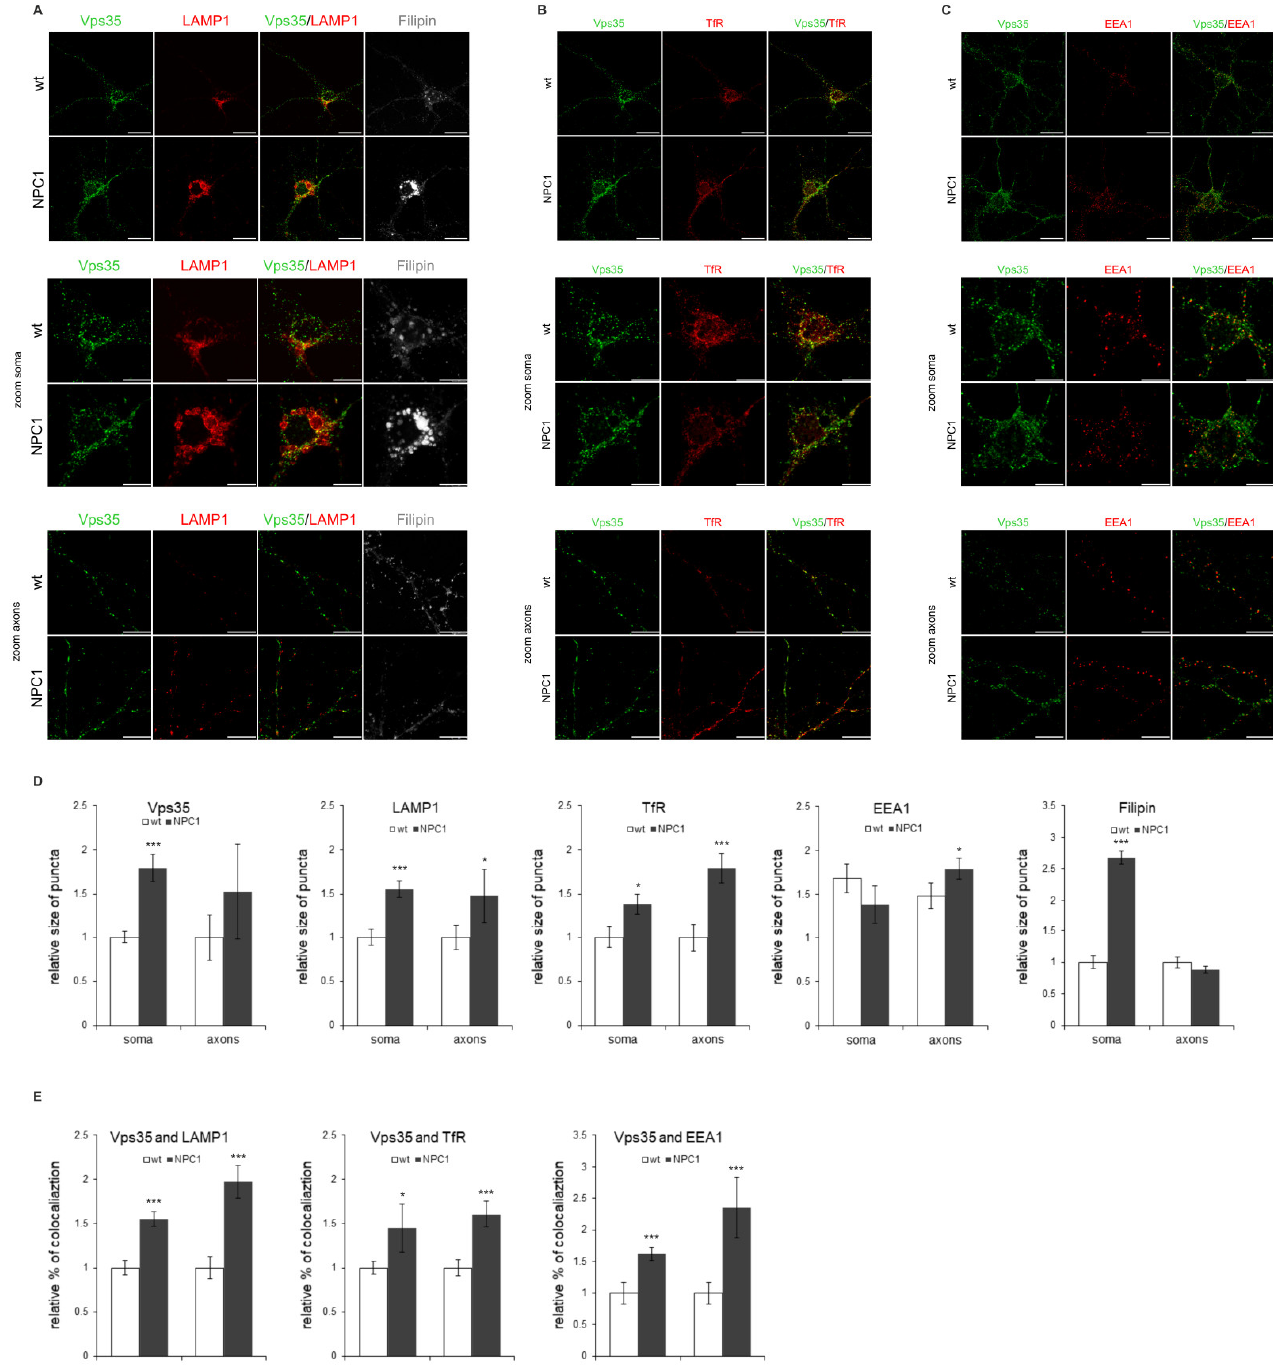
Figure 6. Retromer protein Vps35 accumulates within enlarged endolysosomal EEA1, TfR and LAMP1-positive vesicles in NPC1 hippocampal neurons. Hippocampal neurons were isolated at postnatal day 0 (P0), grown in culture for 14 DIV, fixed and stained for Vps35 (green) and ( A ) lysosomal marker LAMP1 (red), ( B ) transferrin receptor TfR (red) and ( C ) early endosome marker EEA1 (red). Filipin was used for the staining of free cholesterol. Cells were analyzed using confocal microscopy, and fluorescent signals were quantified using ImageJ software. ( D ) Size of Vps35, LAMP1, TfR, EEA1 and filipin-positive vesicles and ( E ) colocalization of Vps35 and EEA1, TfR and LAMP1 in neuronal soma and axons was compared between wt and NPC1 neurons, * p < 0.05, *** p < 0.001. The data are shown as mean ± SD normalized to control, n = 20 neurons per group from three different experiments. Scale bar—20 (unzoomed figures) and 10 µm (zoomed figures).